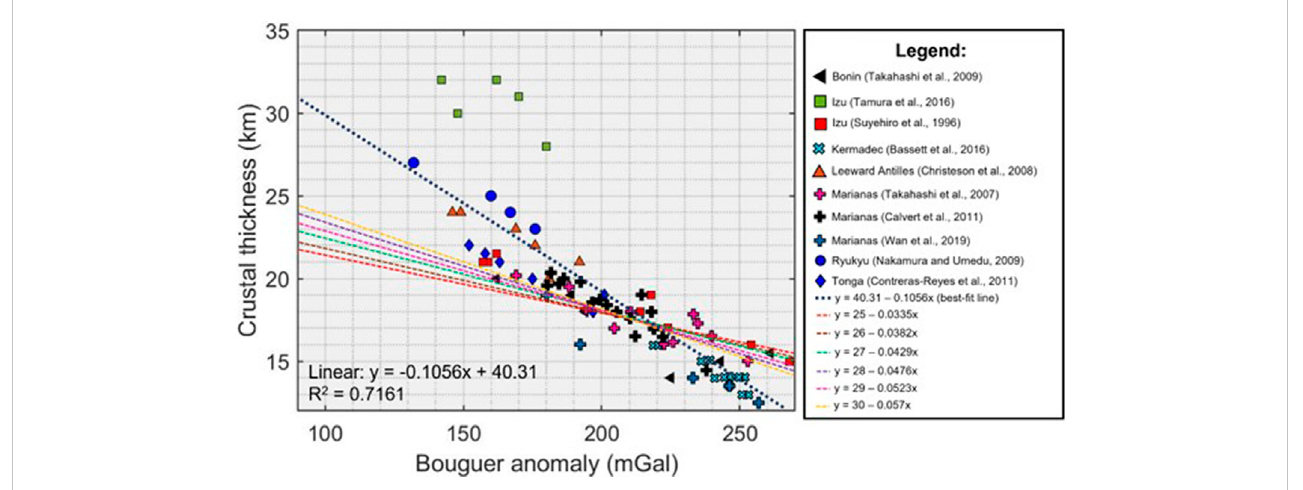
FIGURE 3 Plot showing the other regression curves that fi t the dataset. The intercepts of the selected lines were determined following the average arc crustal thickness reported by Tetreault and Buiter (2014).